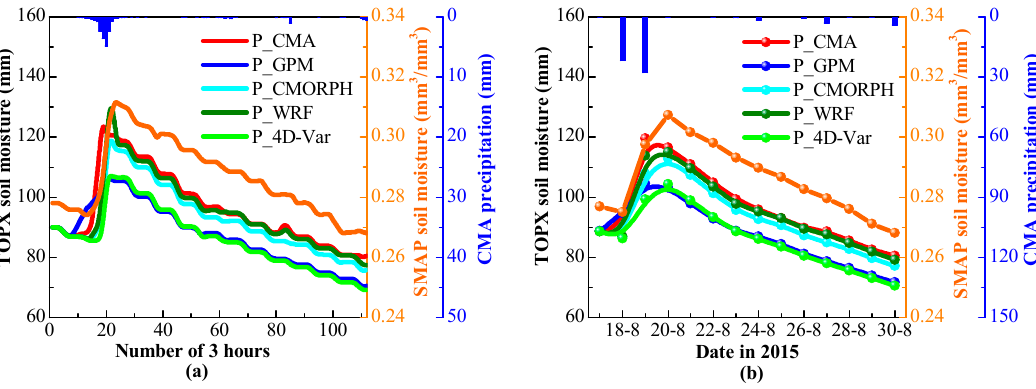
Figure 8. The 3-h ( a ) and daily ( b ) mean values of the WJB watershed soil moisture obtained from the SMAP (mm 3 /mm 3 ) and the different rainfall-runoff experiments based on the TOPX model (mm).